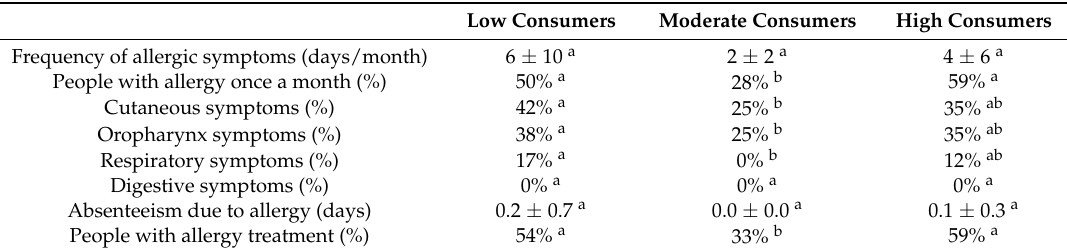
Table 4. Characteristics of allergy in allergic students of the three groups according to their cocoa intake. Results are expressed as percentage or mean ± SDM ( N = 12–24). Different letters mean statistical difference.